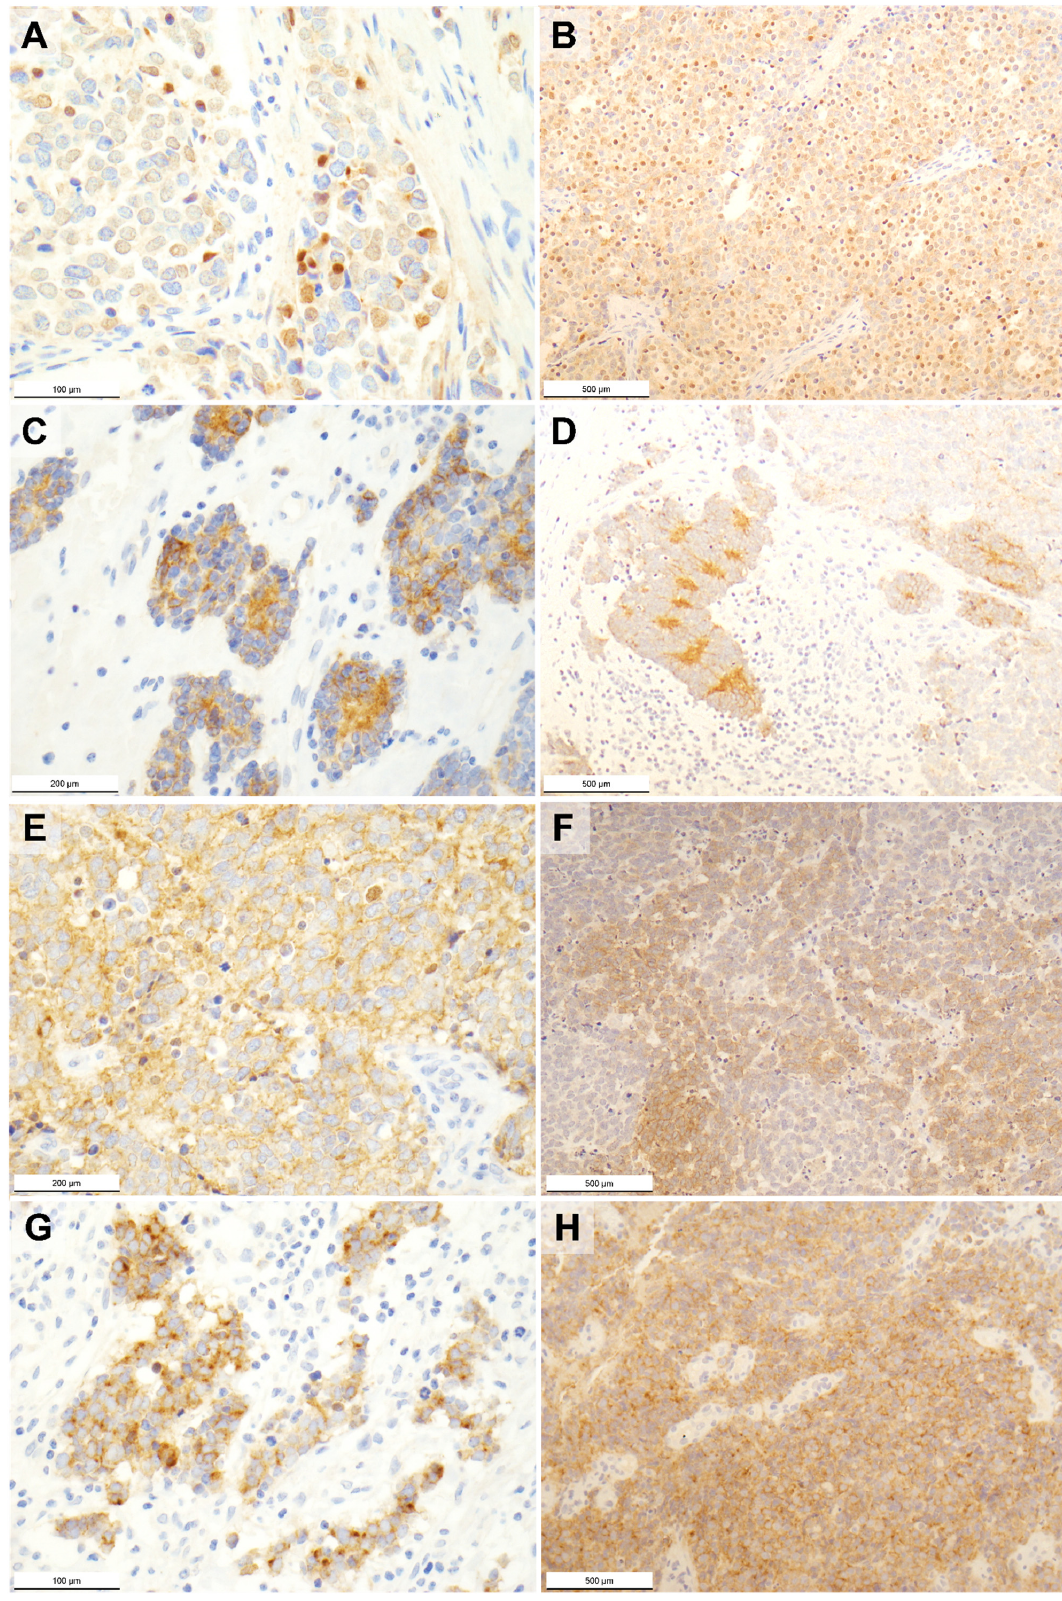
Figure 1. Photomicrographs of pan-TRK immunostained Merkel cell carcinomas showing ( A , B ) nuclear, ( C , D ) cytoplasmic, ( E , F ) membranous, and ( G , H ) dot-like patterns of expression. Original magnification 40 × ( B , D , F , H ), 100 × ( C , E ), and 200 × ( A , G